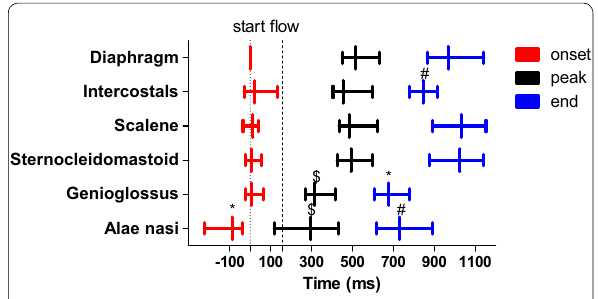
Fig. 3 Relative onset, peak and termination times of extradiaphragmatic inspiratory muscle activity with respect to the onset time of diaphragm activity (time 0 s). There are no differences = in recruitment times between different PS levels; therefore, data are represented as median (interquartile range). For the alae nasi N 61, = genioglossus N 43, sternocleidomastoid N 69, scalene N 70, = = = parasternal intercostals N 64 and diaphragm N 72. *Significantly = = different with other muscles except alae nasi, $ significantly different with other muscles except alae nasi and genioglossus, # significantly different with other muscles except intercostals and alae nasi ( P < 0.05) . Inspiratory flow started significantly later than inspiratory muscle activity ( P <